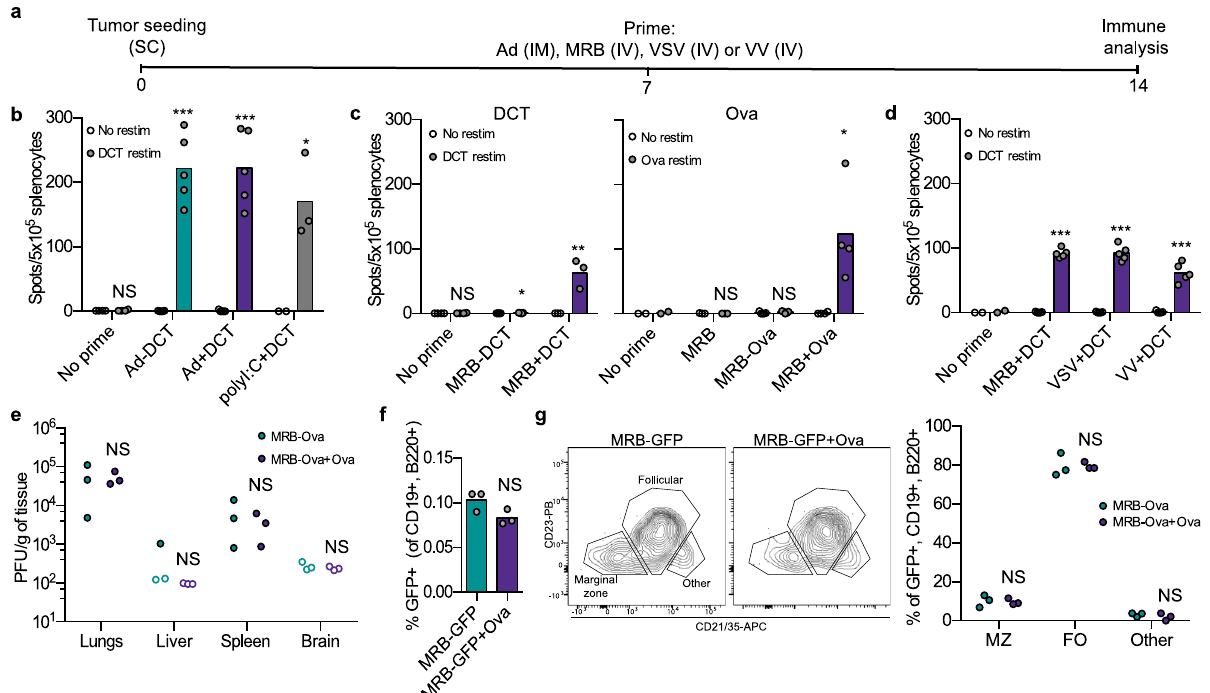
Fig. 1 OVs are effective as adjuvants for immunization. a Treatment schedule used in ( b – d ). All mice were bearing SC B16F10-Ova tumors. b IFN γ ELISPOT analysis of splenocytes from mice immunized with Ad-DCT or Ad or polyI:C co-administered with DCT peptide (all IM) (from left to right; n = 4, 5, 5, and 3); c MRB-DCT, MRB co-administered with DCT peptide (left panel) or MRB-Ova or MRB co-administered with Ova peptide (right panel) (all IV) (from left to right; n = 4, 5, 3, 3, 3, 5 and 4) or; d MRB, VSV or VV co-administered with DCT peptide (all IV) (from left to right; n = 2, 5, 5 and 5). For b – d , the statistical analyses refer to the comparison between the corresponding ex-vivo “ No restim ” and “ restim ” conditions. NS: p > 0.05, *: p < 0.05, **: p < 0.01, ***: p < 0.001 (unpaired two-tailed t -test). e Biodistribution analysis of C57BL/6 mice injected IV with MRB-Ova with or without co-administration of Ova peptide for 24h ( n = 3). f Flow cytometry analysis of GFP + splenocytes from mice injected with MRB-GFP with or without Ova peptide. The spleens were collected 1.5h post-injection, dissociated and cultured ex-vivo for 4.5h prior to staining and analysis. The graph shows the percentage of live B cells (CD19 + , B220 + ) that are GFP + ( n = 3). g Flow cytometry analysis of GFP + , B220 + , CD19 + cells from ( f ) ( n = 3). The contour plots show the gating strategy to distinguish different subsets of B cells and the right graph shows the quanti fi cation of the marginal zone (MZ), follicular (FO) and other B cell populations. NS: p > 0.05 (unpaired two-tailed t -test). Source data are provided as a Source Data fi le. Exact p values can be found in the Source